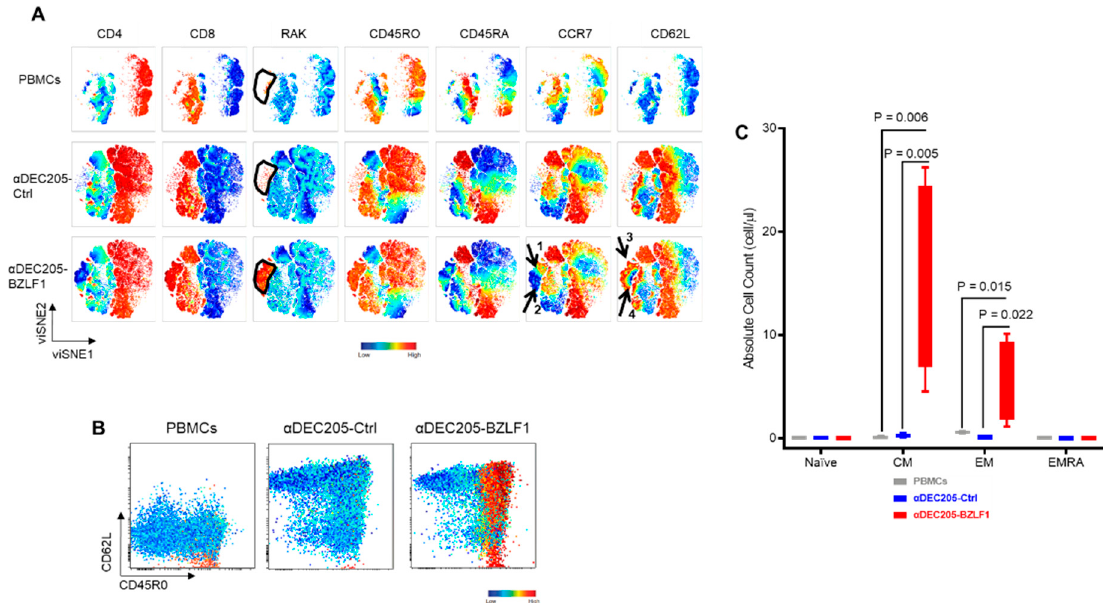
Figure 2. Characteristics of EBV-specific cells in the CoCx: ( A ) The viSNE maps, colored by the intensities of individual immune marker expression (CD4, CD8, RAK, CD45RO, CD45RA, CCR7, and CD62). For each marker tested, cells were separated according to the expression of particular marker. RAK+ memory T-cells generate on the α DEC205-BZLF1 CoCx were evenly distributed between the CCR7+ (black arrow 1) and CCR7 − (black arrow 2). Majority of the RAK+ cells expanded on the α DEC205-BZLF1 are CD62L+ (black arrow 3) while fewer were CD62L − (black arrow 4); ( B ) Biaxial plots of CD8+ T-cells with CD45RO on the X -axis versus CD62L on the Y -axis. Events on the biaxial plots colored according to the RAK intensity expression which confirmed that the memory EBV-specific cells from the PBMCs and α DEC205-Ctrl lack the lymphocyte homing marker, CD62L, while the majority of the RAK+ cells generated from the α DEC205-BZLF1 are CD62L+; ( C ) RAK+ naïve and memory subsets calculated from PBMCs, α DEC205-Ctrl CoCx, and α DEC205-BZLF CoCx across 4 HLA-B8